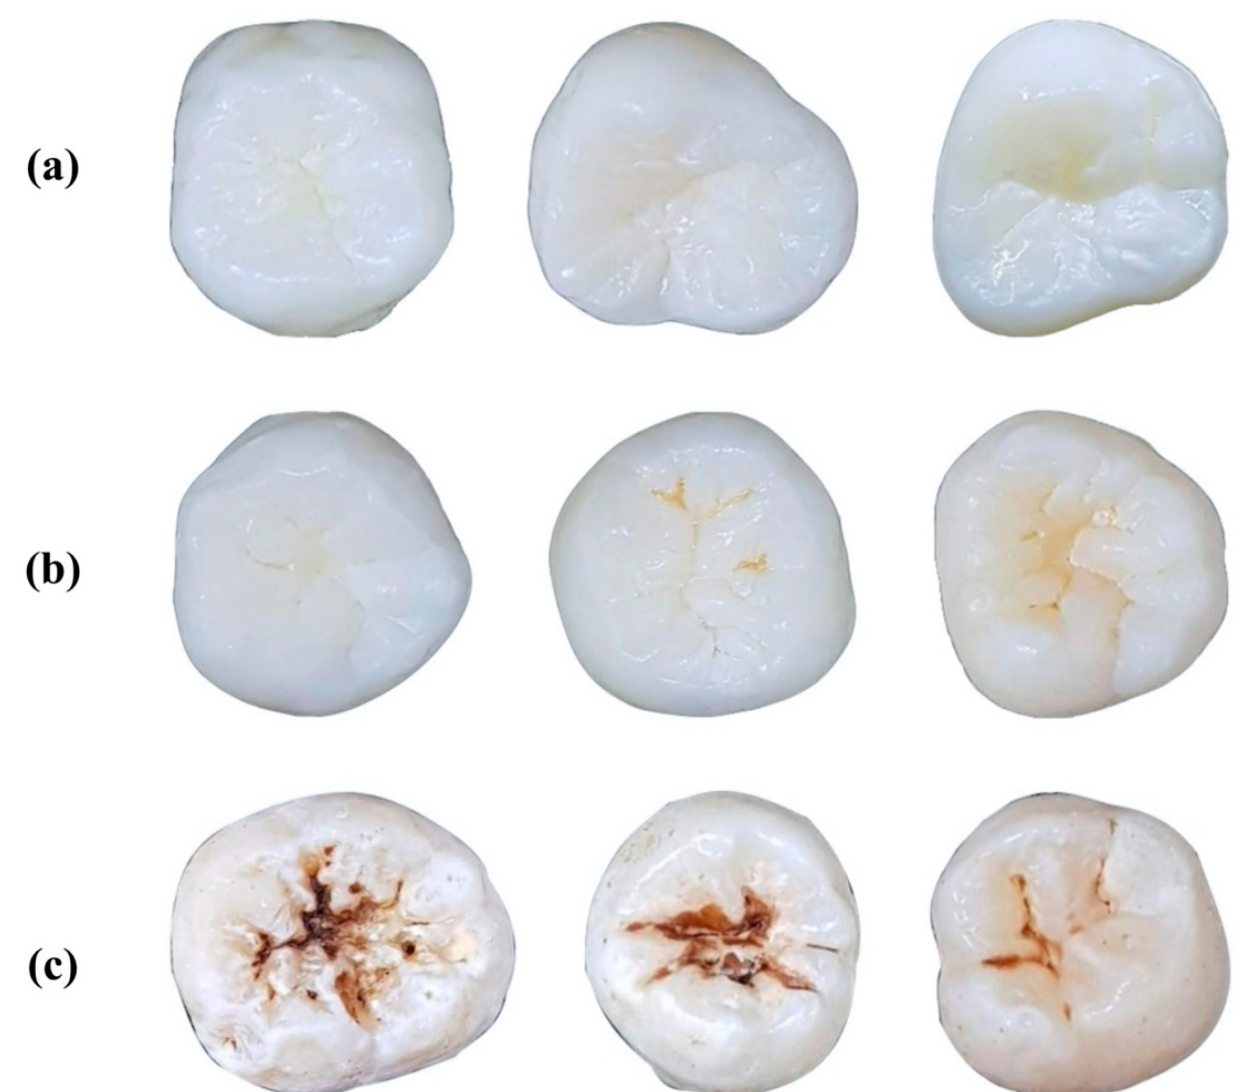
Figure 2. Examples of dataset. ( a ) No Surface Change class; ( b ) Visually Non-Cavitated class; ( c ) Cavitated class.